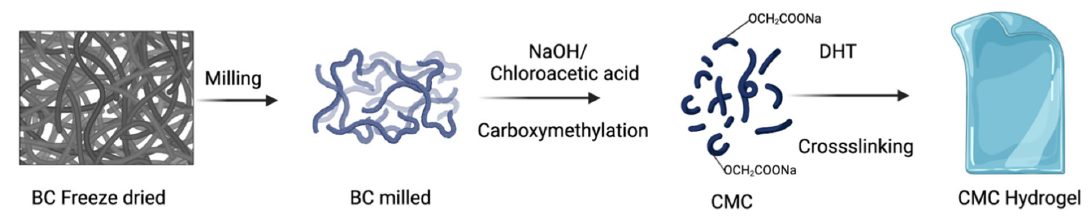
Figure 6. Schematic representation of the synthesis of CMC hydrogel.